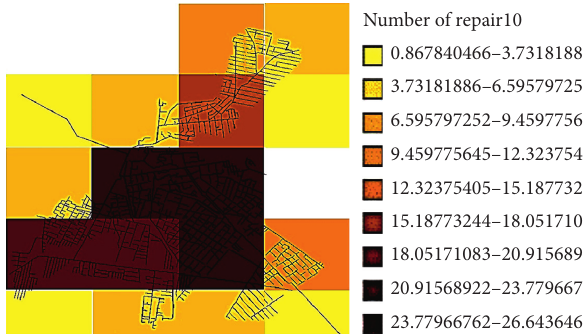
Figure 23: The total number of Hazus SR2 damage under PGA10%.